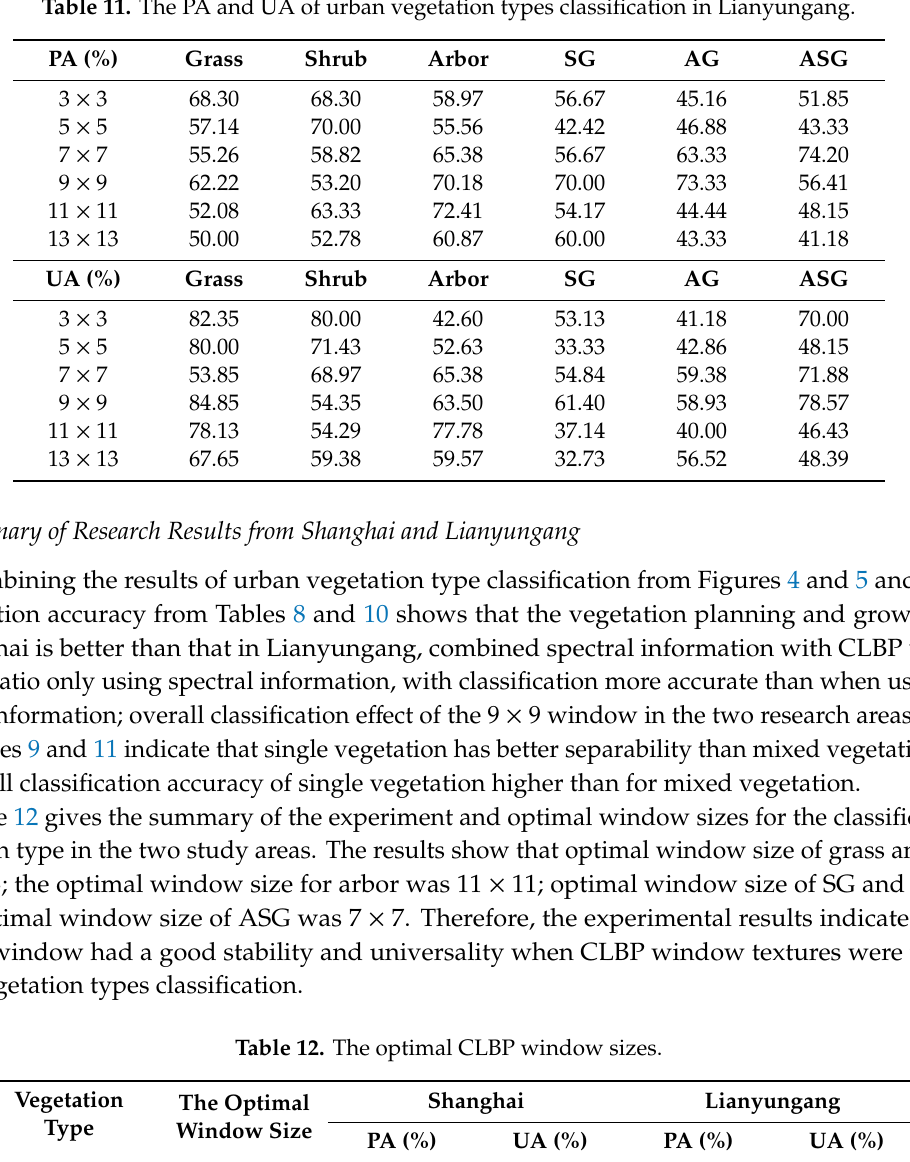
Table 11. The PA and UA of urban vegetation types classification in Lianyungang.